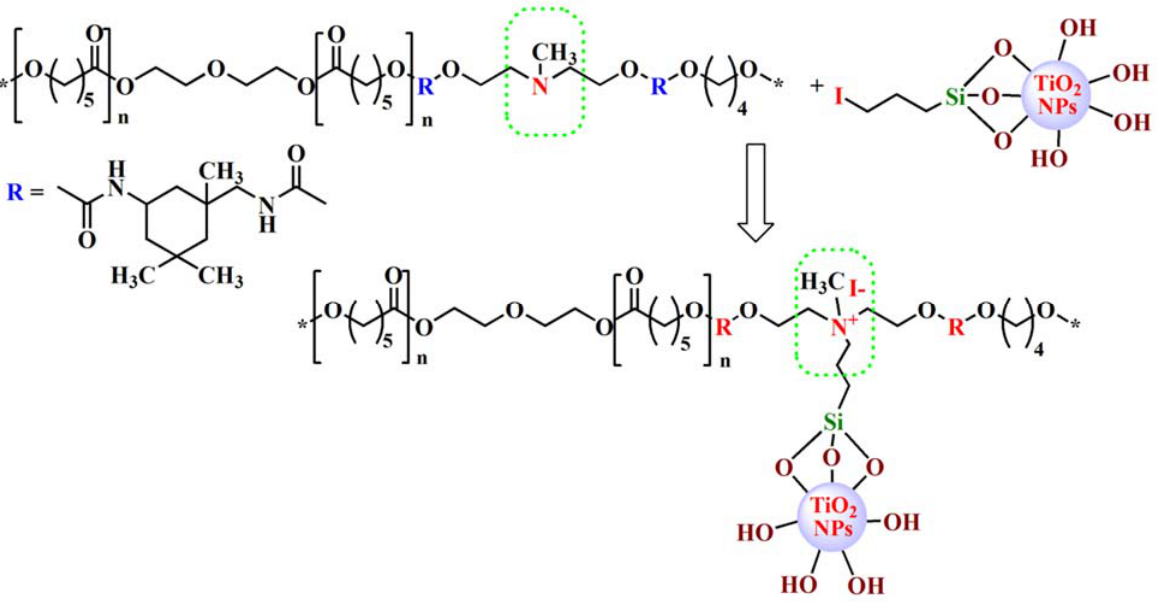
Figure 2. Representation of quaternization reaction between PU-1 and TiO 2 -f nanoparticles.